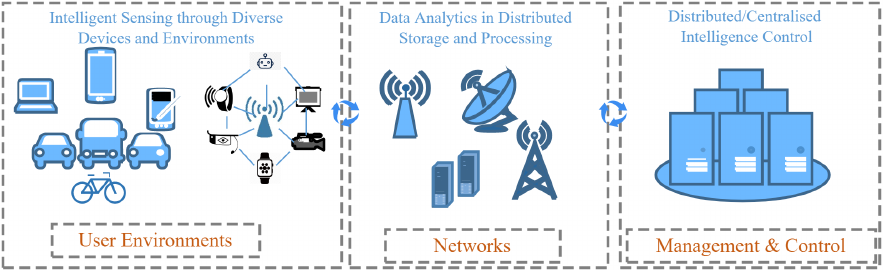
Figure 1. An abstract representation of enabling intelligence in 6G